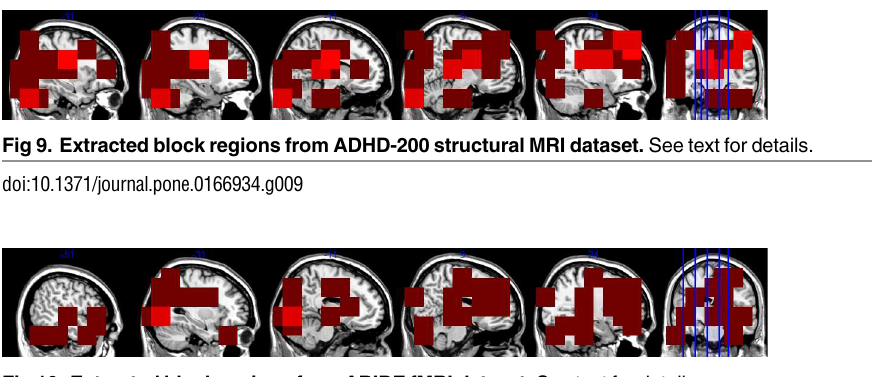
Fig 10. Extractedblock regions from ABIDE fMRI dataset. See text for